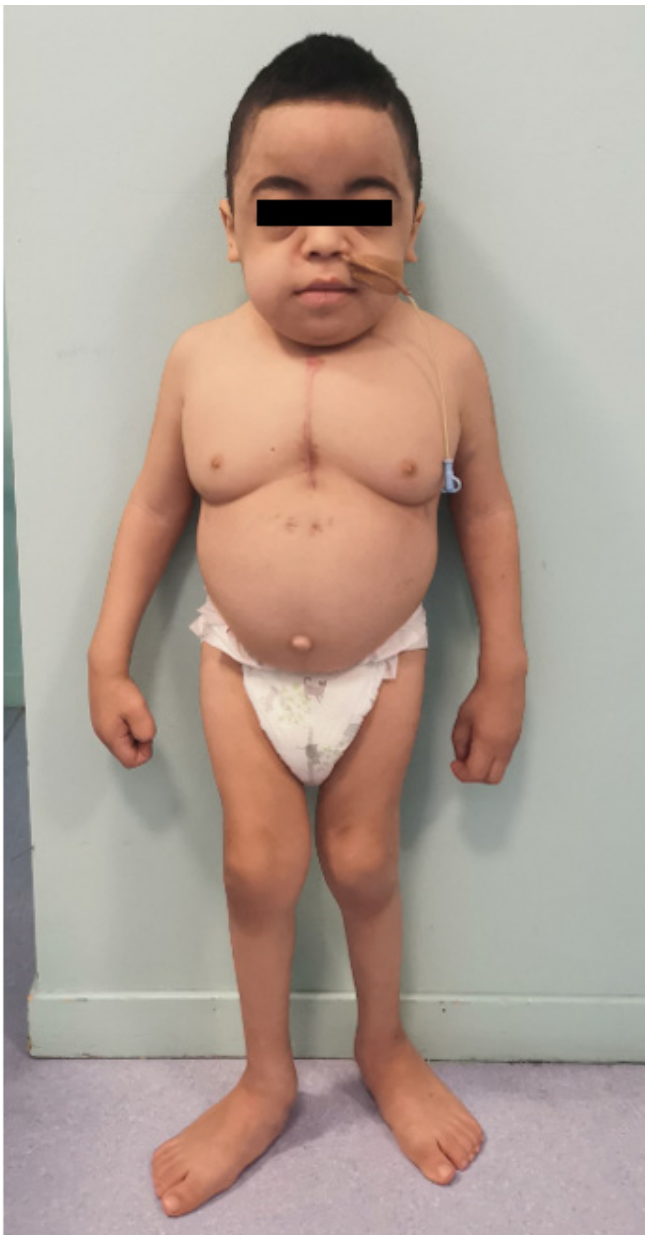
Figure 2. clinical phenotype of the patient at six years old . Figure 2. Clinical phenotype of the patient at six years